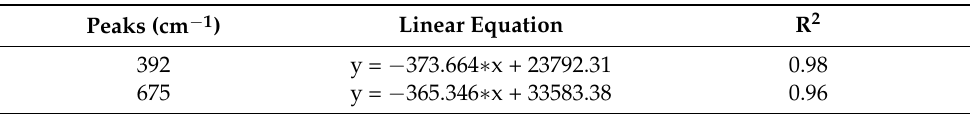
Table 5. Linear relationship between concentrations of mixed pesticide and Raman intensities on apple surfaces.